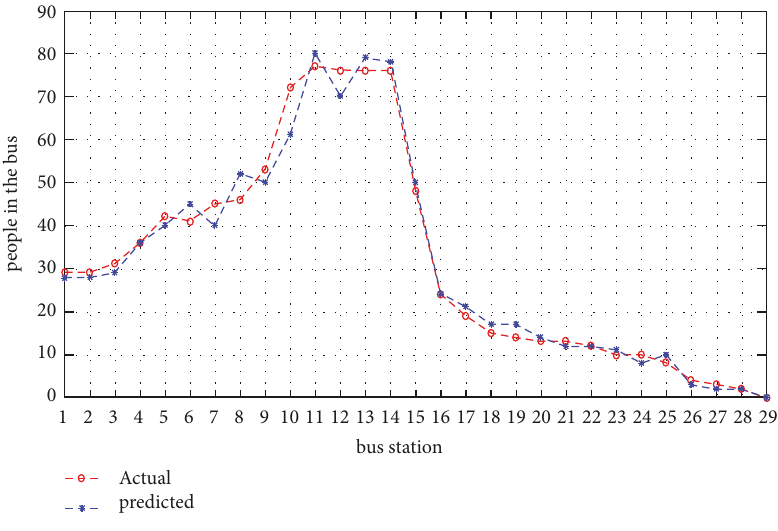
Figure 3: Prediction value of RBF neural network.